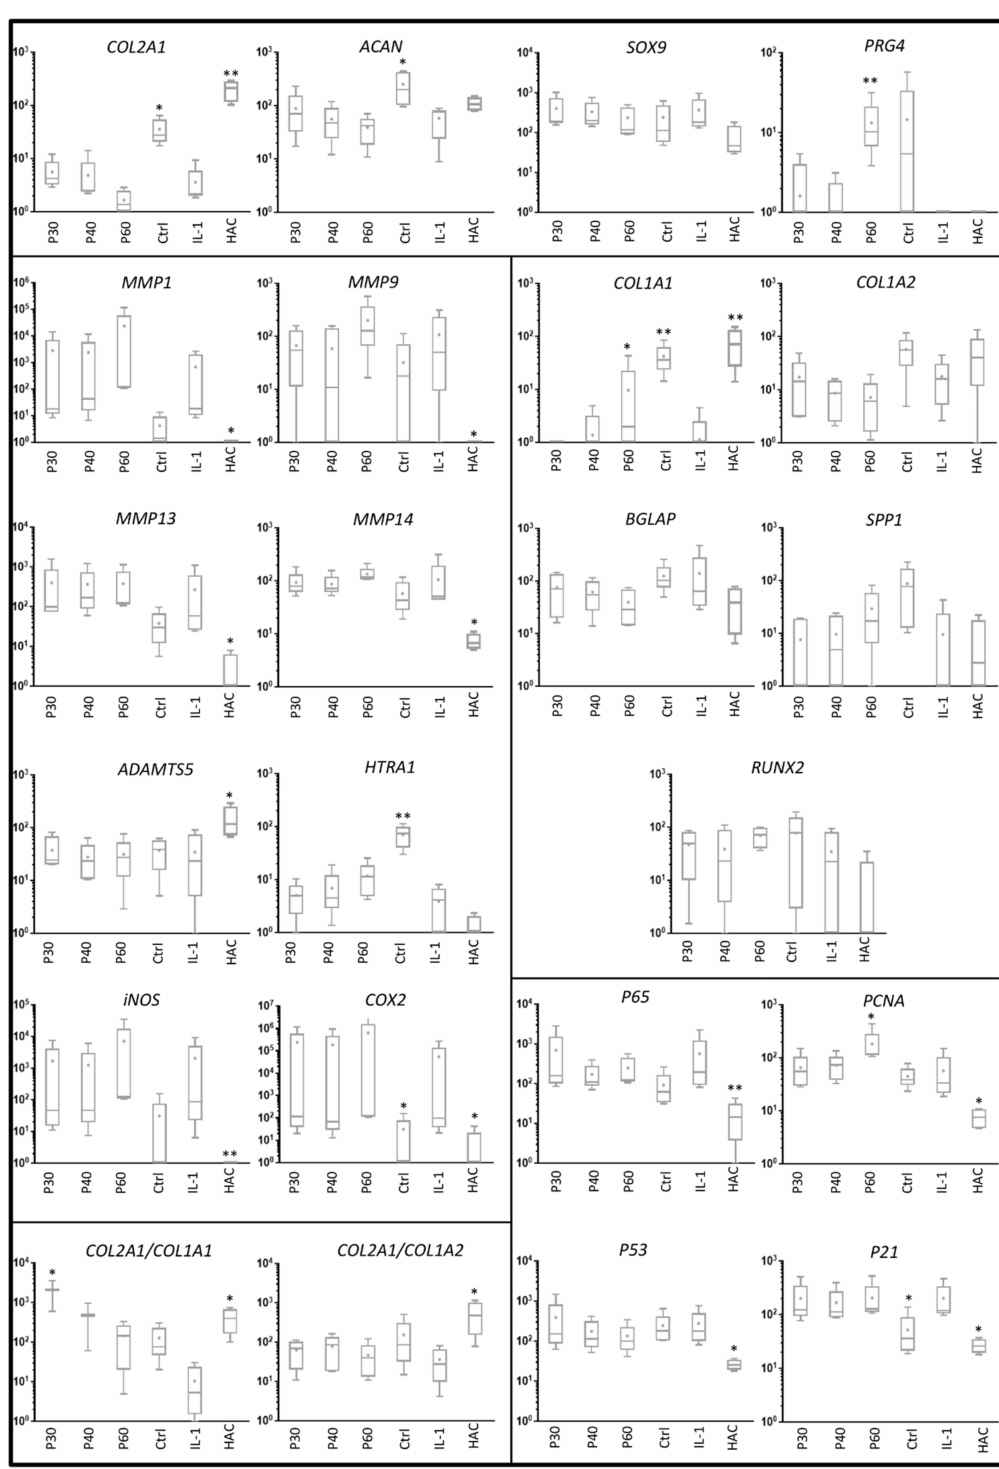
Figure 9. Effect of high concentrations of Promerim ® 30, 40 and 60 on gene expression profile in human articular chondro- cytes. Human articular chondrocytes were grown in type I/III collagen sponges at (P2) for 7 days in hypoxia treated with or without IL-1 β (10 ng/mL) or the presence of 100 µ g/mL Promerim ® 30, 40 or 60 at (P30, P40, P60). Results are summarized in box plots ( n = 5) showing the mean (cross) and the median (line) of relative mRNA expression estimated using RT-qPCR and normalized to the β -ACTIN and PPIA reference genes. The COL2A1 : COL1A1 and COL2A1 : COL1A2 ratios are given. HAC: mRNA obtained from human articular chondrocytes at P0 were used as controls, Ctrl: chondrocytes were grown in type I/III collagen sponges in the absence of IL-1 and Promerim ® . Statistical analyses were performed using the two-way ANOVA followed by Dunnett’s multiple comparison post-test (* p < 0.05; ** p < 0.01) compared with the IL-1